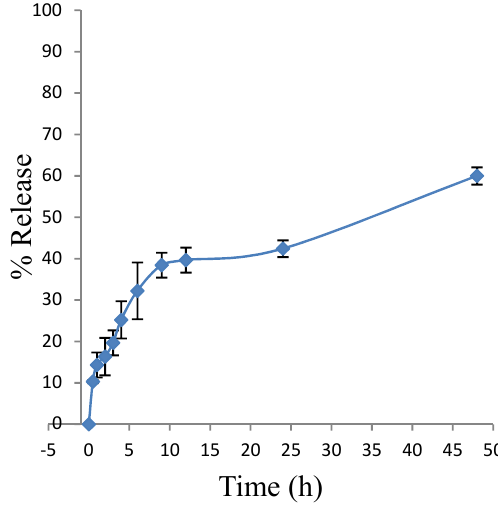
Figure 14. Drug release study of micelles made of Y-shaped polymer-VLB